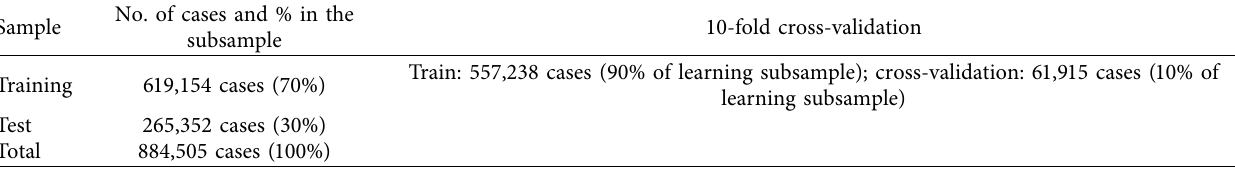
Table 2: Sampling procedures used for modeling.